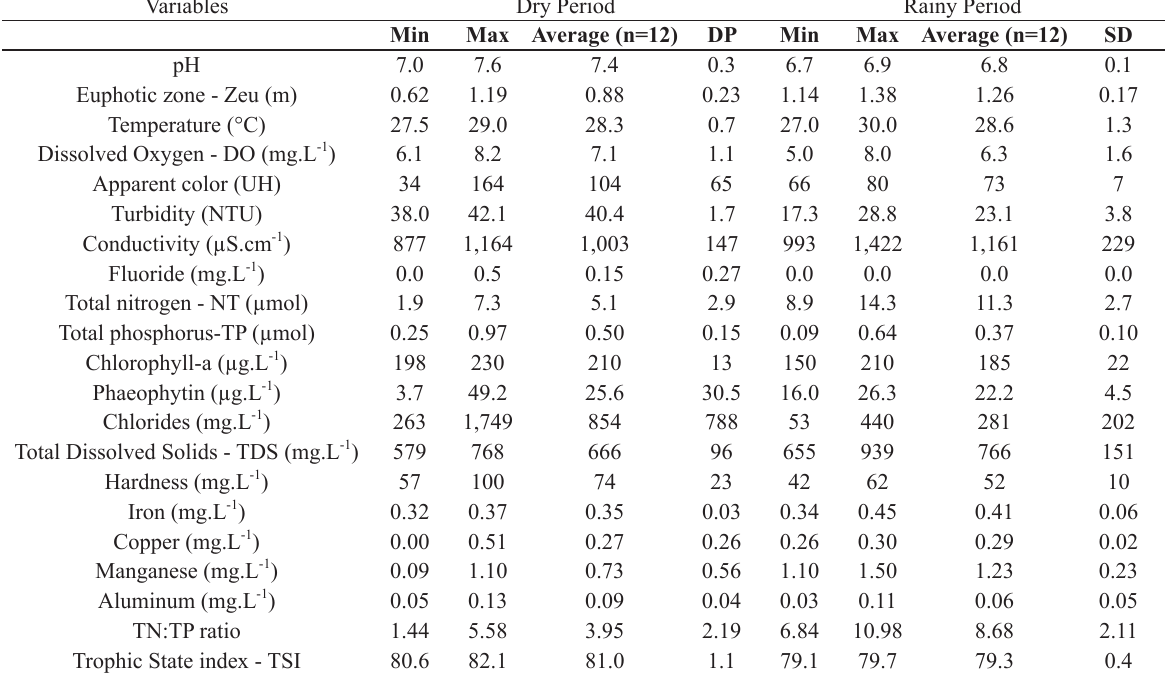
Values of variables in the Apipucos reservoir, Pernambuco, Brazil, between December 2011 and November 2012; Min = minimum value; Max = maximum value; SD = standard deviation.